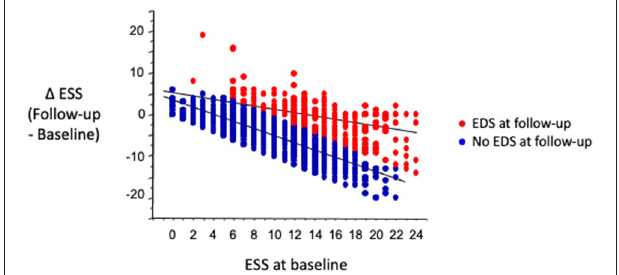
FIGURE 4 | In patients sleepy at baseline, slope of relationship between change in ESS ( 1 ESS, EDS at follow-up minus EDS at baseline) and baseline ESS was much lower in patients with than in patients without EDS at follow-up. Equations describing regressions are in patients with EDS at follow-up (red dots): 1 ESS = 5.35 – 0.41 • ESS at baseline; R 2 = 0.29, p < 0.001; in patients without EDS at follow-up (blue dots): 1 ESS: 3.35–0.80 • ESS at baseline; R 2 = 0.68, p <